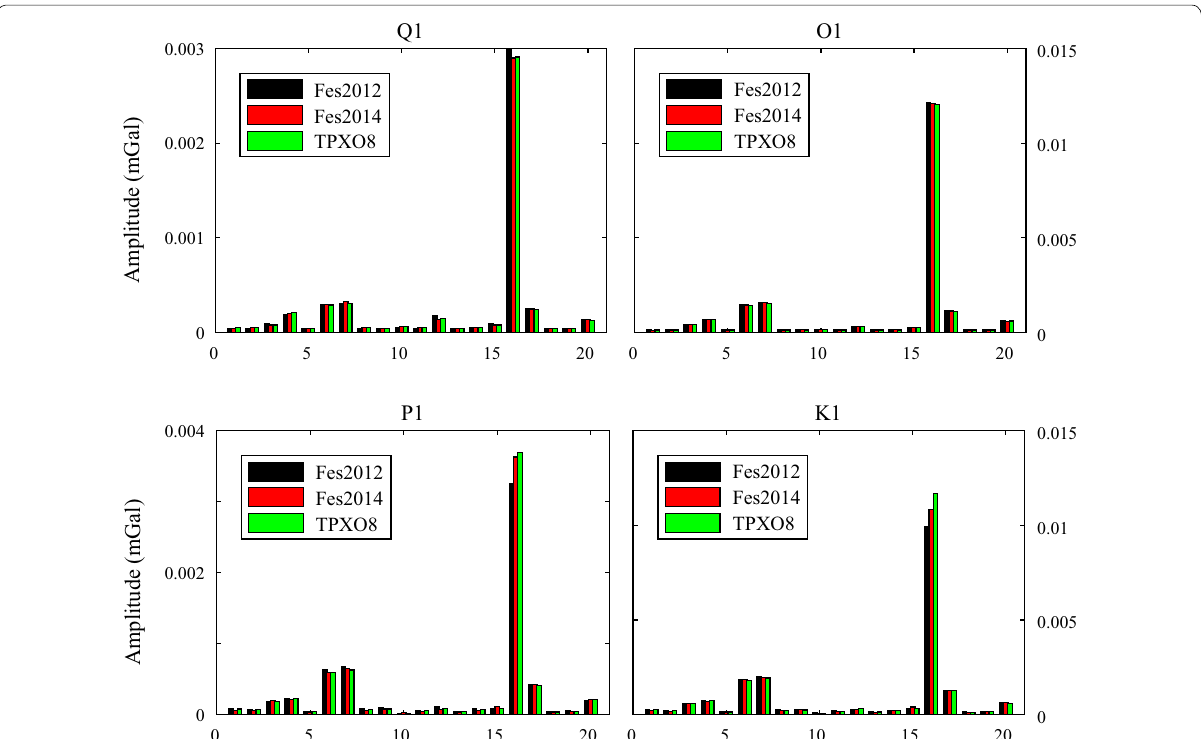
Fig. 4 Ocean tide loading effects of 4 diurnal tidal waves from three newest ocean tide models at 20 global SG stations. The horizontal axis represents the station order which follows the station numbers in Table